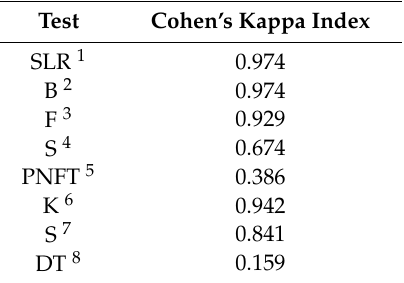
Table 4. Results of the reliability of the